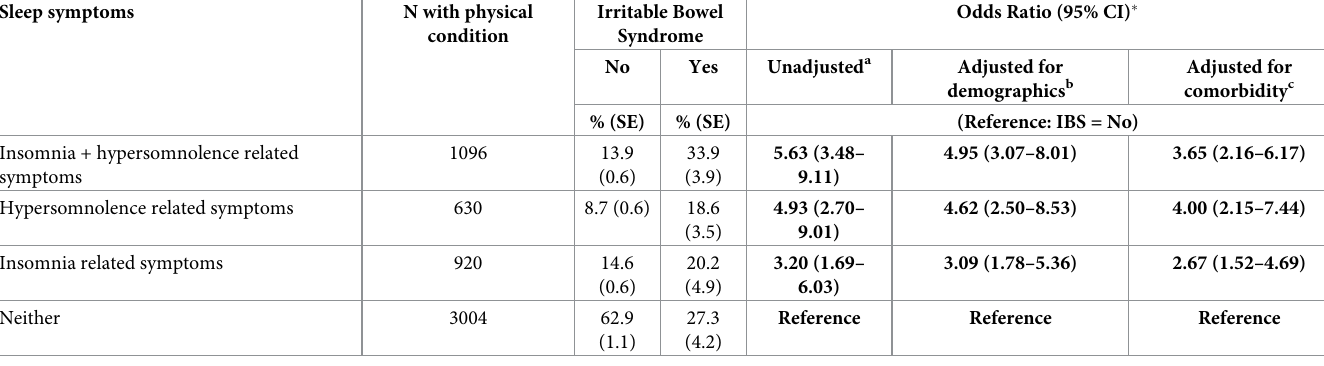
Table 4. Prevalence, unadjusted and adjusted risk of symptom-based sleep disturbances in the adult IBS cohort in the NCS-R Part II survey. Sleep symptoms N with physical